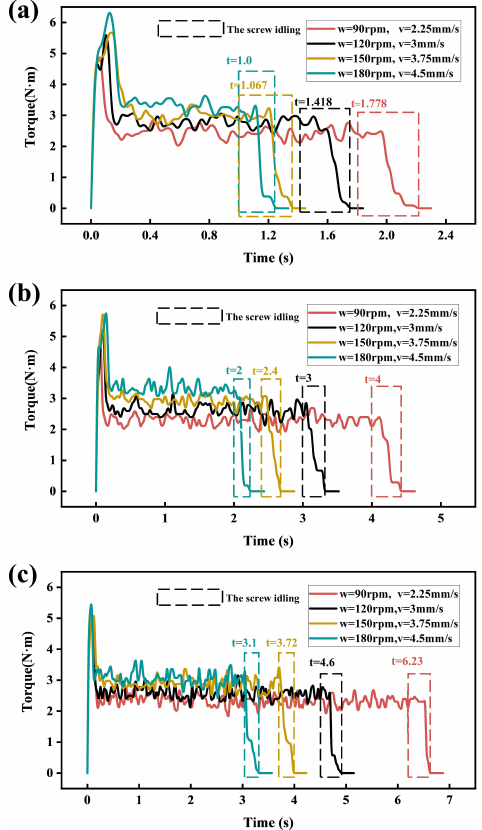
Figure 23. Variations in the torque of the three screws under different settings. ( a ) #1 screw. ( b ) #2 screw. ( c ) #3